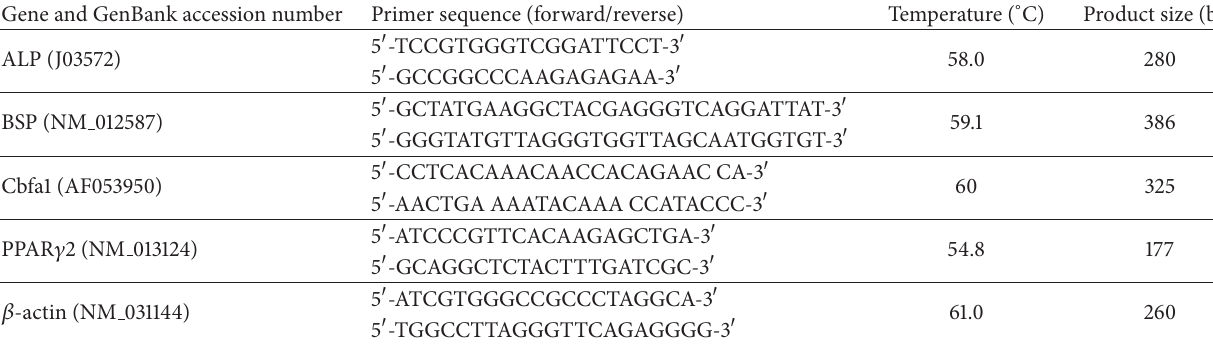
Table 1: PCR primer sequences and cycling